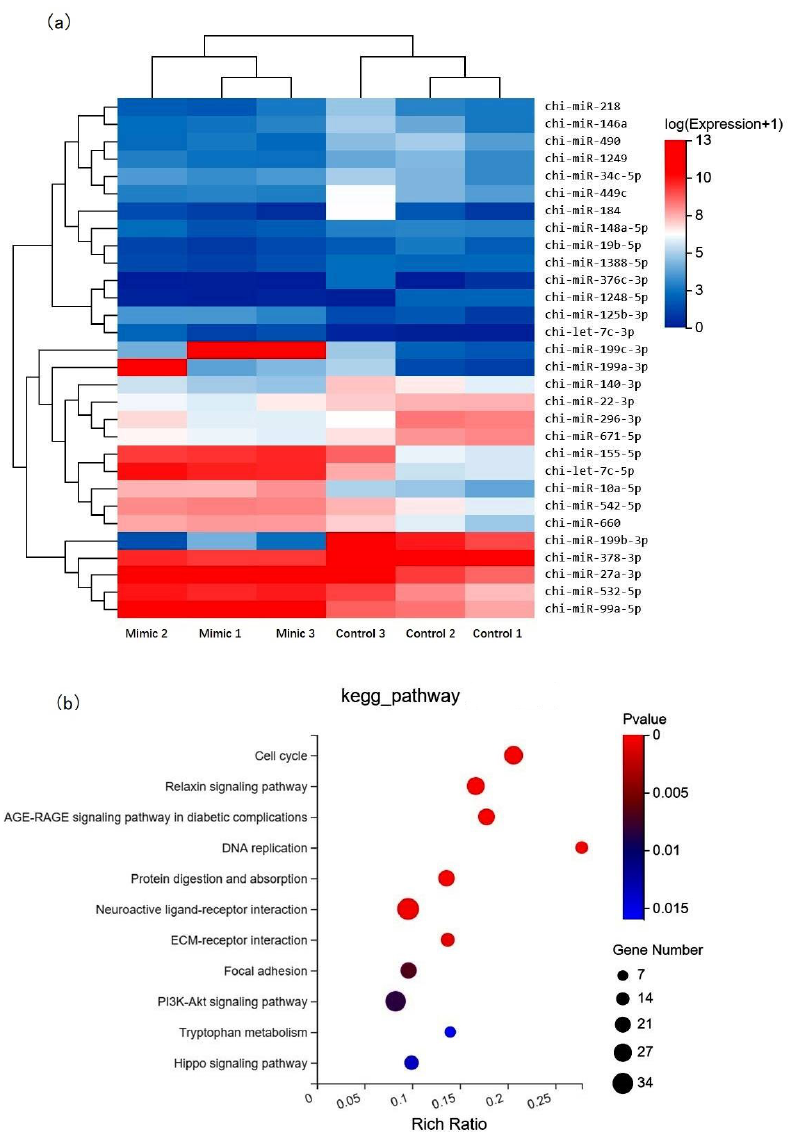
Figure 5. Differentially expressed miRNA expression in SMSCs after miR-99b-3p overexpression. ( a ) Heat map of known DE miRNAs in SMSCs after chi-miR-99b-3p overexpression. ( b ) KEGG functional analysis DE miRNA in SMSCs after chi-miR-99b-3p upregulation.